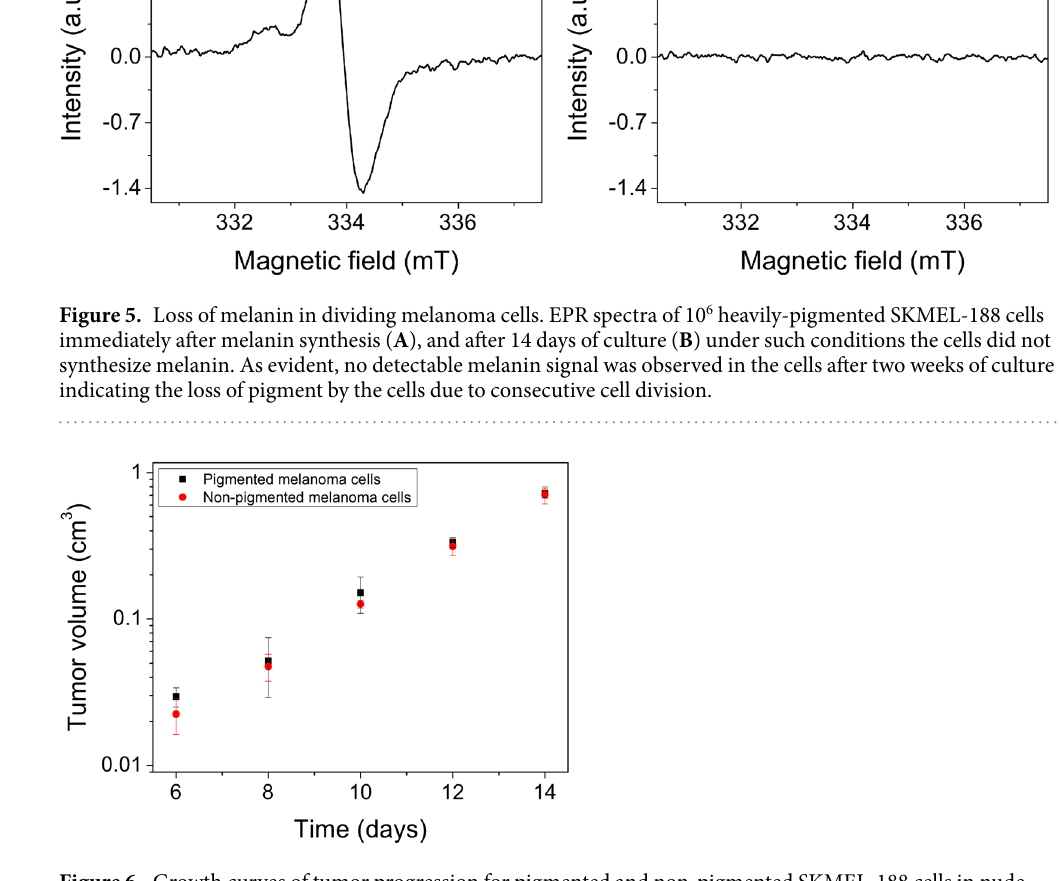
Figure 6. Growth curves of tumor progression for pigmented and non-pigmented SKMEL-188 cells in nude mice. Tumor volume (y axis) is plotted in logarithmic scale. To determine the volume of the tumors, the oblate spheroid approximation was used. In calculation of the spheroids volume, the two horizontal axes were averaged giving the equatorial diameter of a spheroid, whereas tumor height indicated half of the spheroid’s polar